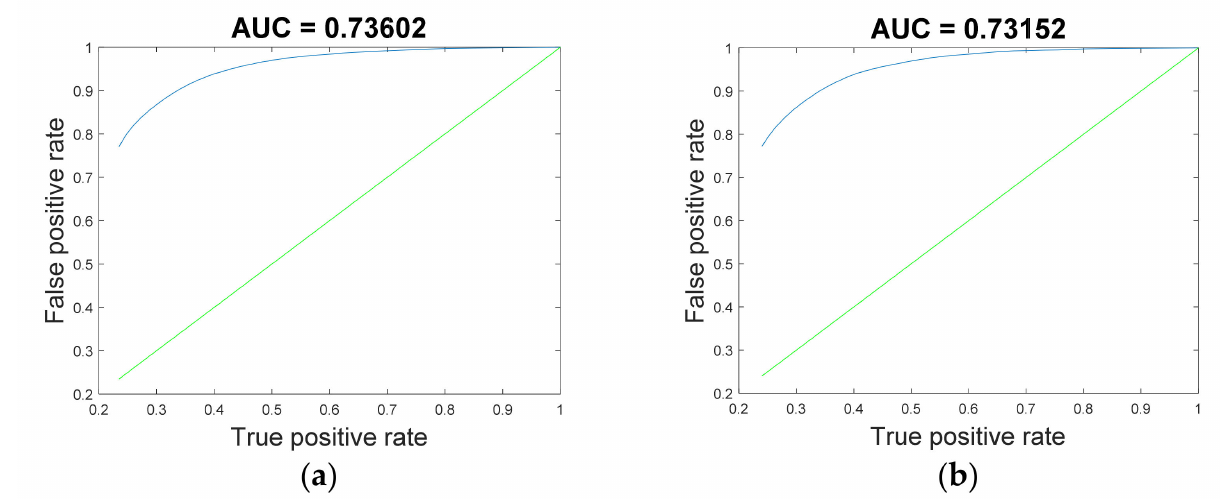
Figure 17. The receiver operating characteristic curve of RF in the cross-session experiment. ( a ) S1-S2; ( b ) S2-S1.